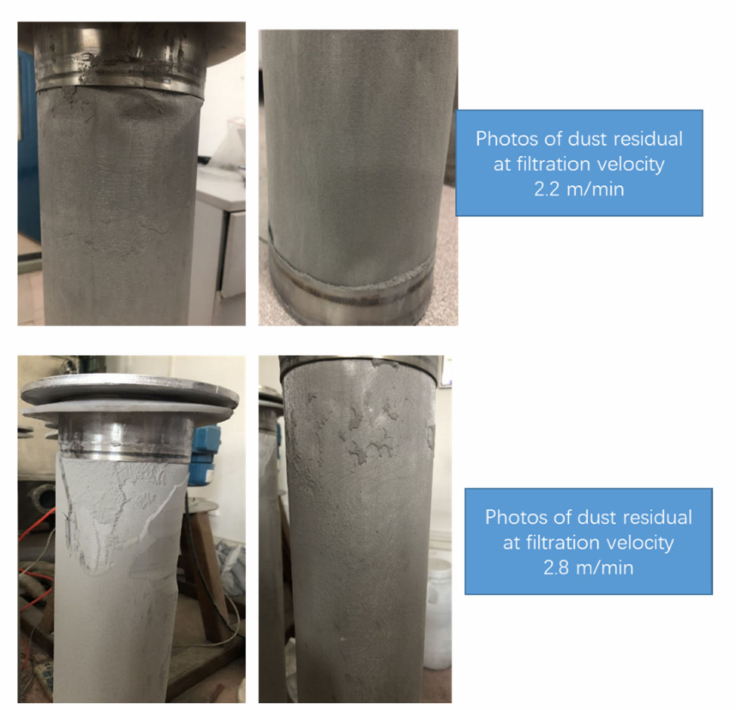
Figure 14. The photos of residual dust at filtration velocities of 2.2 and 2.8